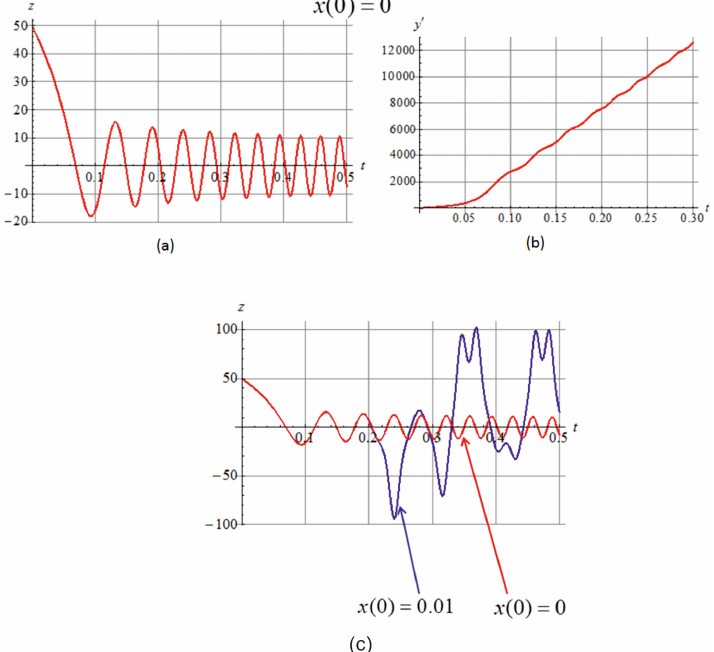
Figure 1. (a) Oscillations over z at x( 0 ) = 0. (b) Time dependence of the velocity ˙ y (t) at x( 0 ) = 0. (c) Comparison of the initial time dependence z(t) for x( 0 ) = 0 (red curve) and x( 0 ) = 0 . 01 (blue